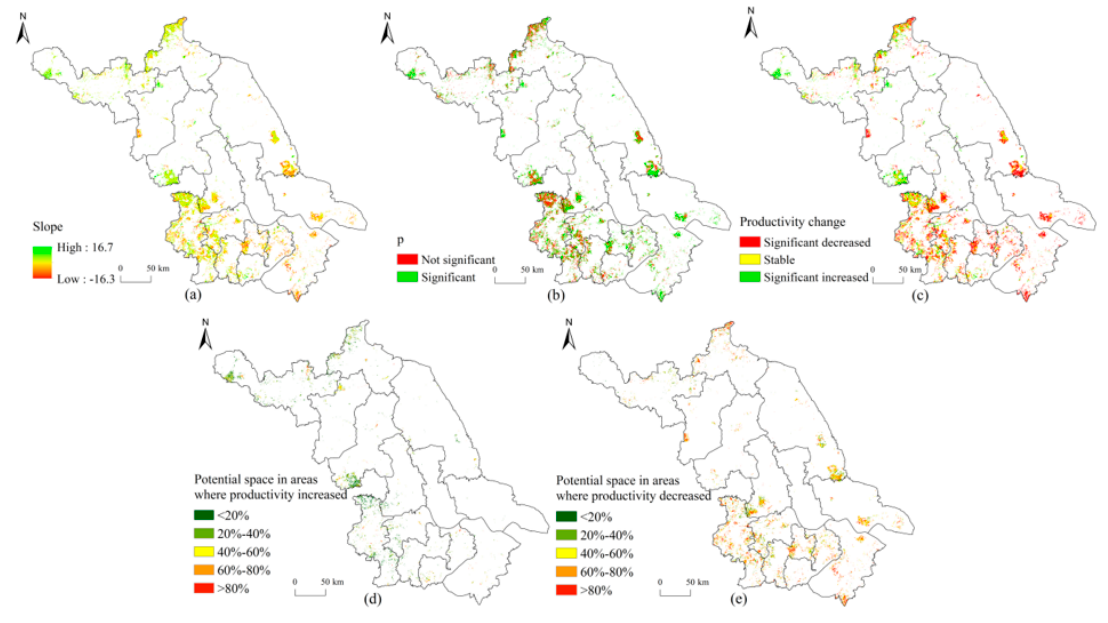
Figure 6. Slope, p, productivity changes, and potential space of single cropping system. ( a ) the slope of the linear regression equation; ( b ) the significance of the productivity changes ( p < 0.05); ( c ) the productivity changes; ( d , e ) the productivity potential space of a single cropping system in an area with a significant change in